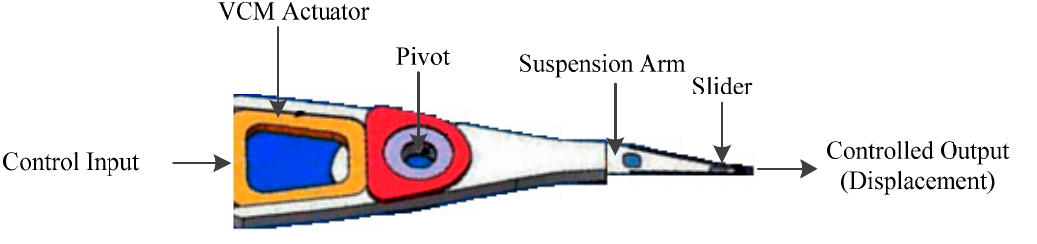
Figure 1. Single-stage actuation system .